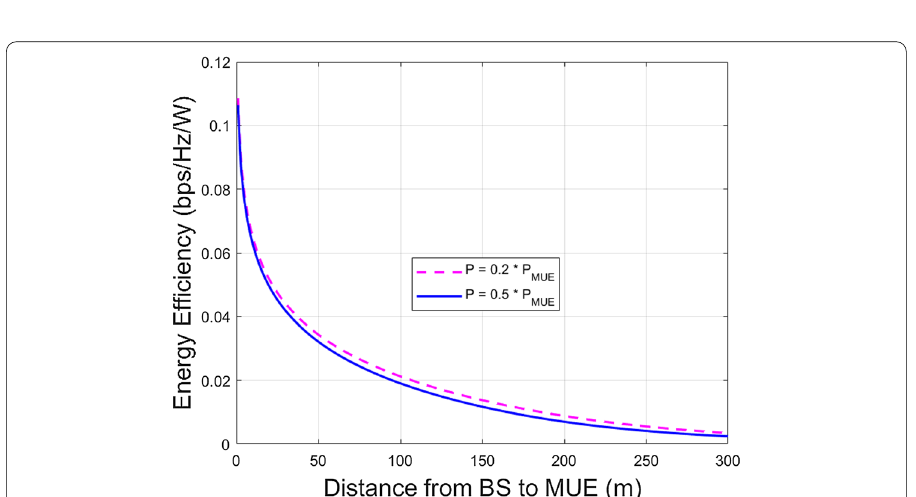
Fig. 9 Energy efficiency vs. distance from BS to MUE in